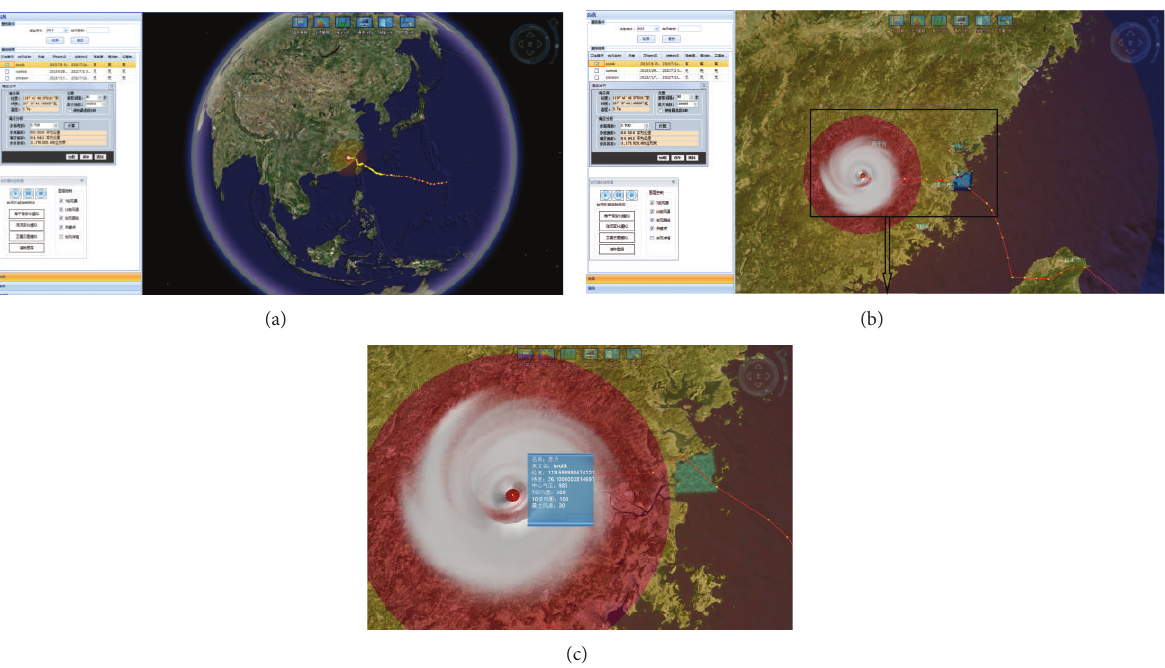
Figure 6: Layout of GVS client and typhoon